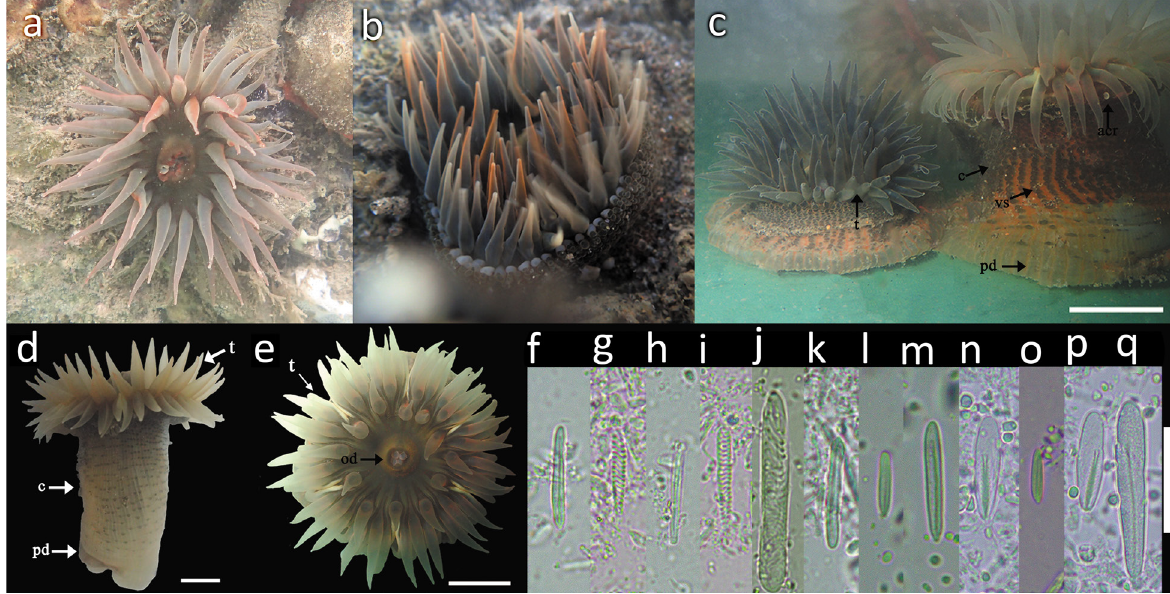
Figure 3. Bunodosoma cavernatum (Bosc, 1802). a-b Live specimen in natural habitat. c Lateral view of two different specimens. d Lateral view. e Oral view. f-q Cnidae. - tentacle: f basitrich g spirocyst; acrorhagi: